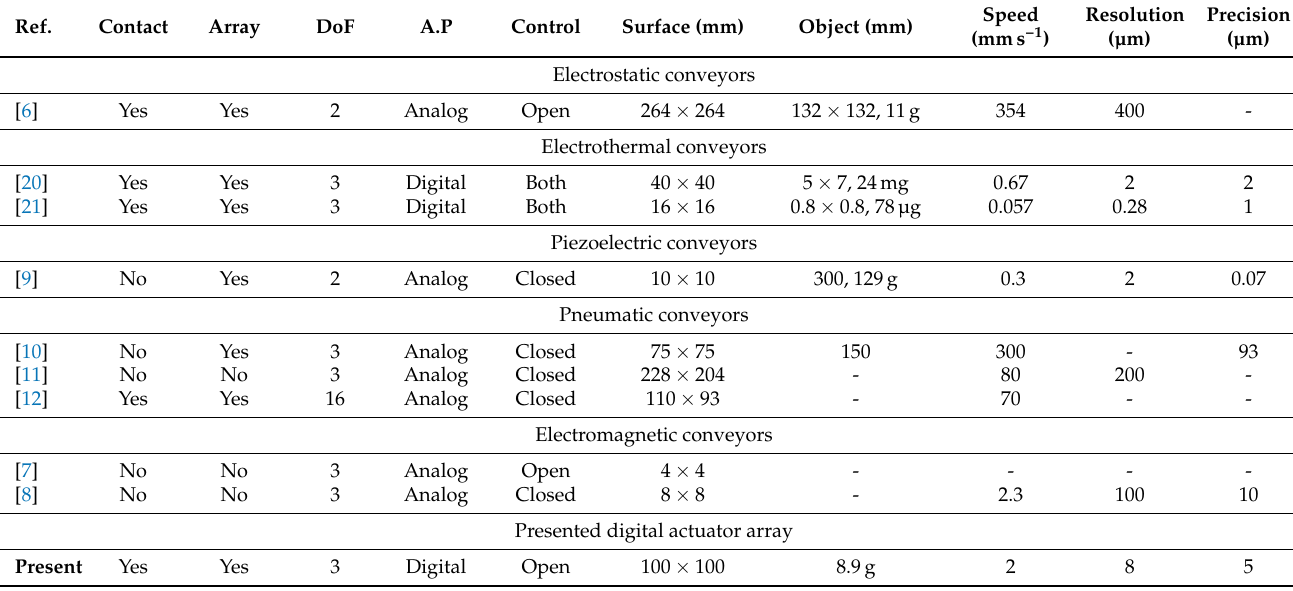
Table 2. Literature